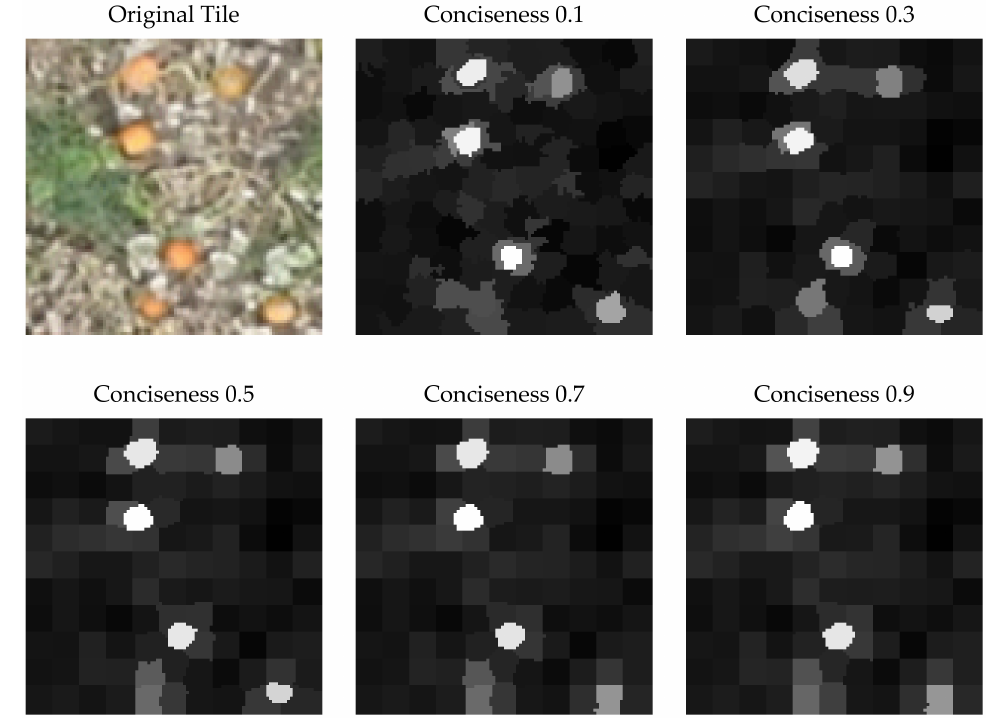
Figure 6. Results of segmentation with different conciseness parameter values. Pumpkin segmentation threshold differentiates between pumpkins and background in the reference-gathering stage and is dependent on parameter threshold_r . Due to superpixel size or vegetation obstacles, not all pumpkin superpixels contain a clear pumpkin